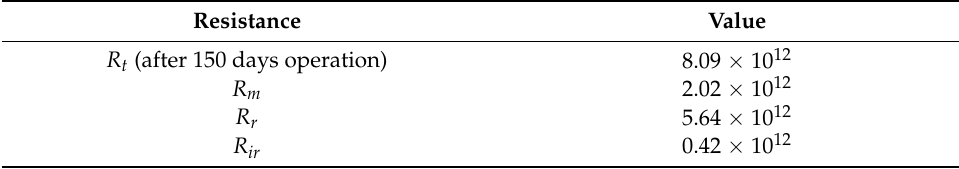
Table 1. The calculated values for R t , R m , R r and R ir